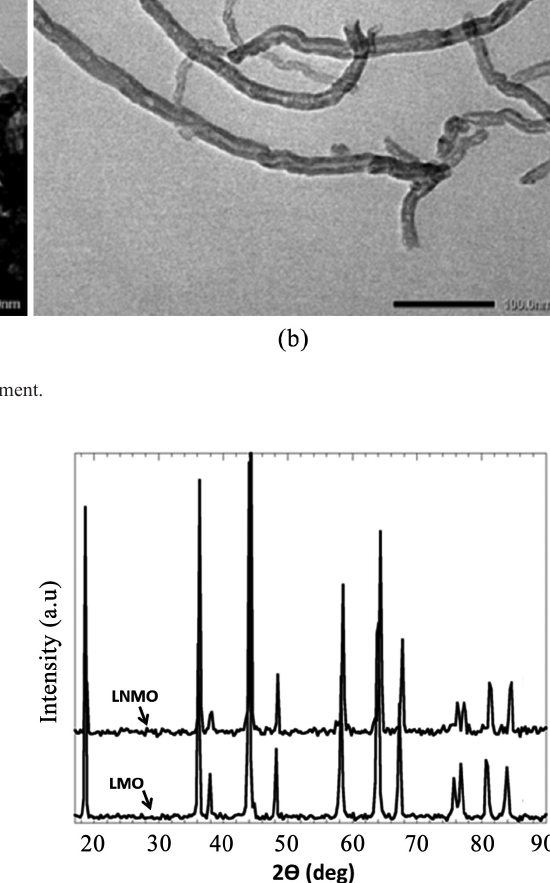
Figure 4 . XRD patterns of LMO and LNMO